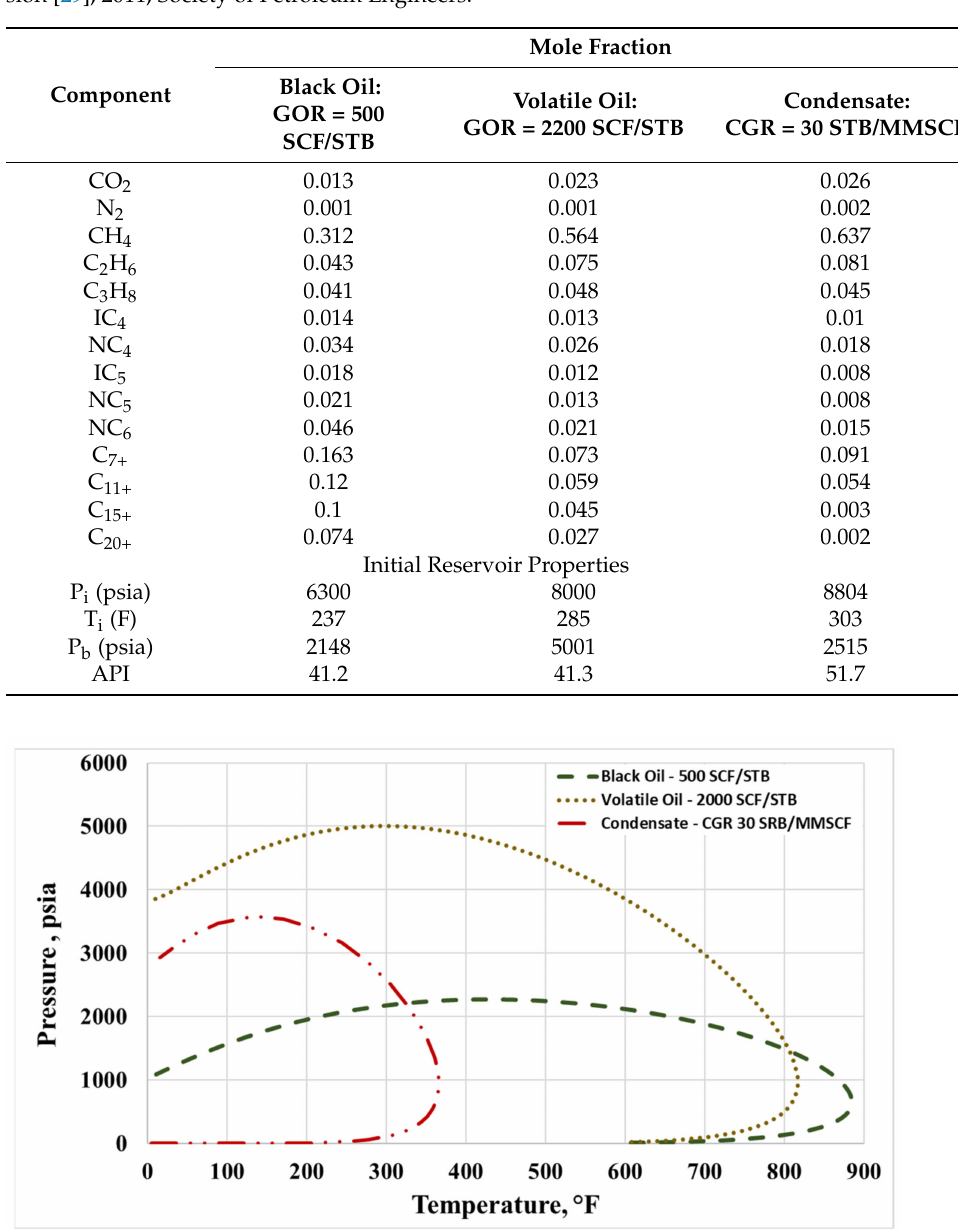
Figure 3. P-T diagrams for three Eagle Ford fluids, including gas condensate, volatile oil, and black